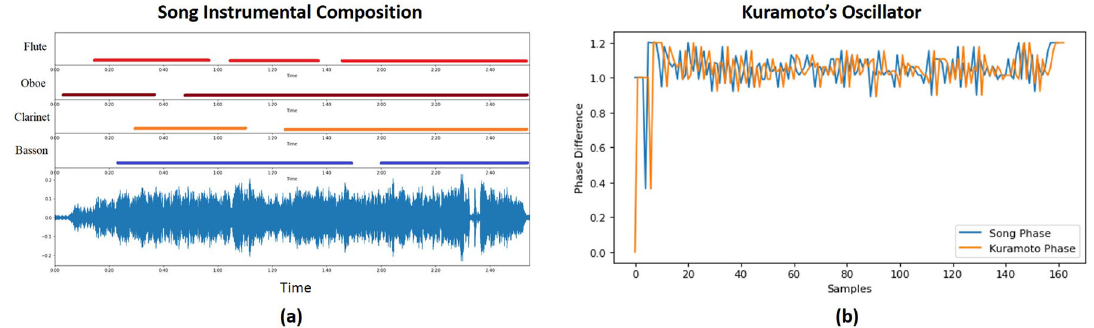
Fig. 4 Phase synchronization for multi-instrumental composition with dynamic leader changes. a Multi-instrumental orchestra composition with leader transition across four woodwind instruments along with time-varying tempo. b Phase Synchronization achieved between musical piece with different leader and Kuramoto Oscillator for generating tap sound on every beats is seen to observe close similarity (Blue line shows the musical composition and orange line denotes the Kuramoto ’ s phase). Bach ’ s composition titled “ The Art of Fugue ” , which is 2:55 min long, was obtained from www2.ece.rochester.edu/